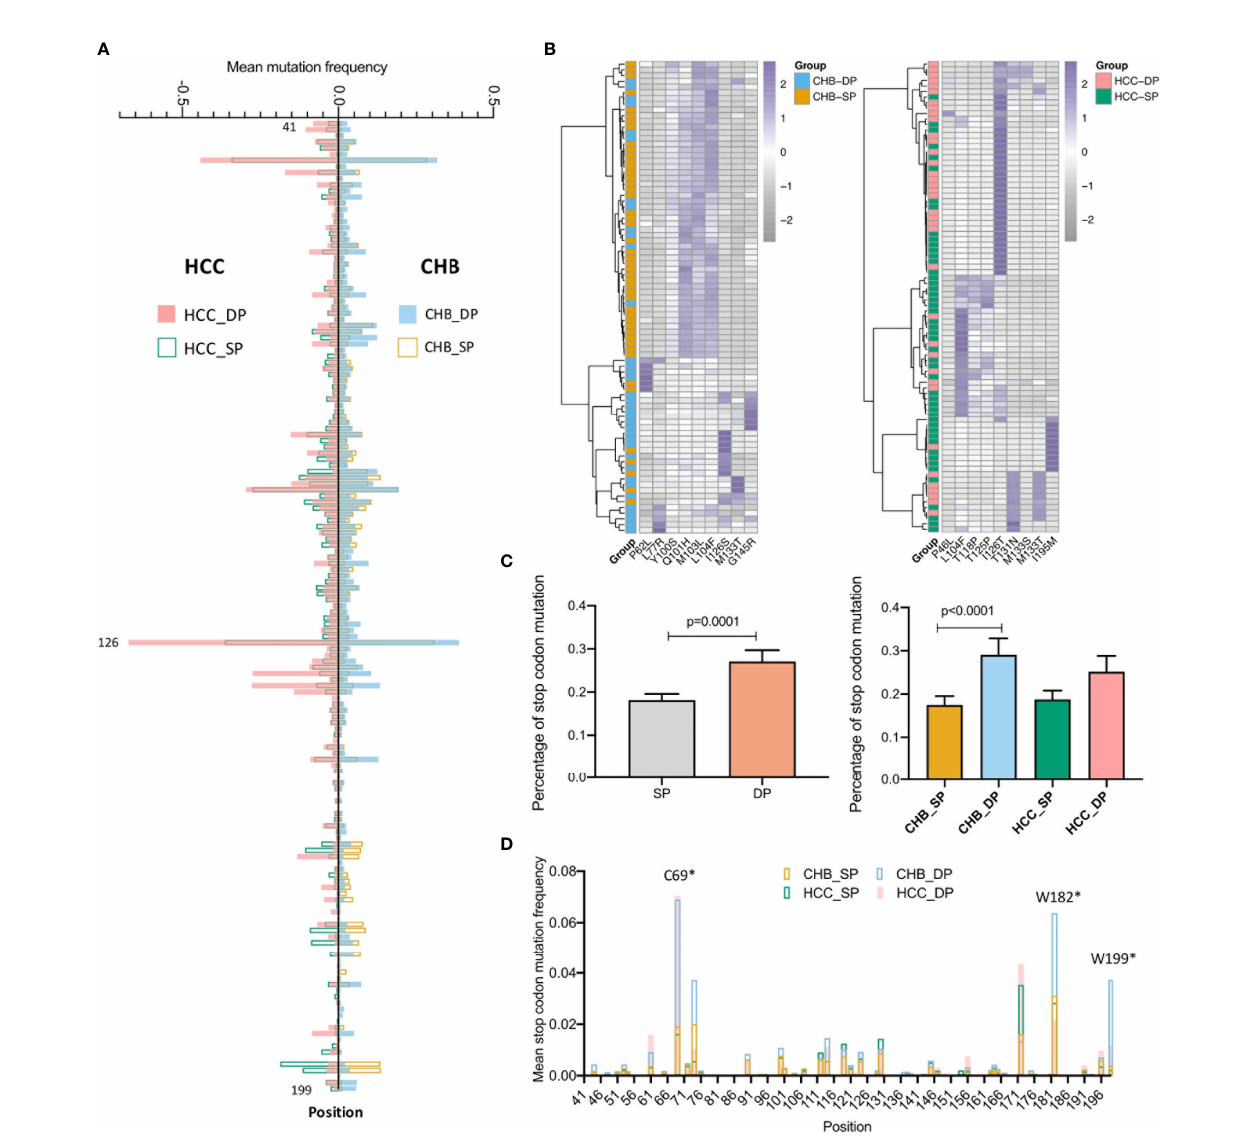
FIGURE 2 | Comparison of differential mutations between double-positive (DP) and single-positive (SP) groups in chronic hepatitis B (CHB) and hepatocellular carcinoma (HCC) patients. (A) The barplot demonstrates differential average mutation frequency of each position in the HBV s41 – 199 region between SP and DP groups for CHB and HCC patients. (B) The majority of DP and SP patients in both CHB and HCC can be well-classi fi ed by the hierarchical clustering based on high-frequency mutation sites, which were de fi ned as a mutation rate ≥ 5% of the total reads in each position and differential mutated between SP and DP groups in CHB and HCC patients using both the unpaired Wilcoxon test and Fisher ’ s exact test. (C) The top histogram demonstrates different percentages of stop codon mutations in HBV s41 – 199 region between all SP and DP patients, and the bottom represents different percentage of stop codon mutations in subgroups among CHB_SP (yellow), CHB_DP (light blue), HCC_SP (green), and HCC_DP (pink) patients. Statistical signi fi cance was evaluated using the unpaired Wilcoxon test. (D) The barplot demonstrates differential average stop codon mutation frequency of each position in the HBV s41 – 199 region between SP and DP groups for CHB and HCC patients. *represents stop codon